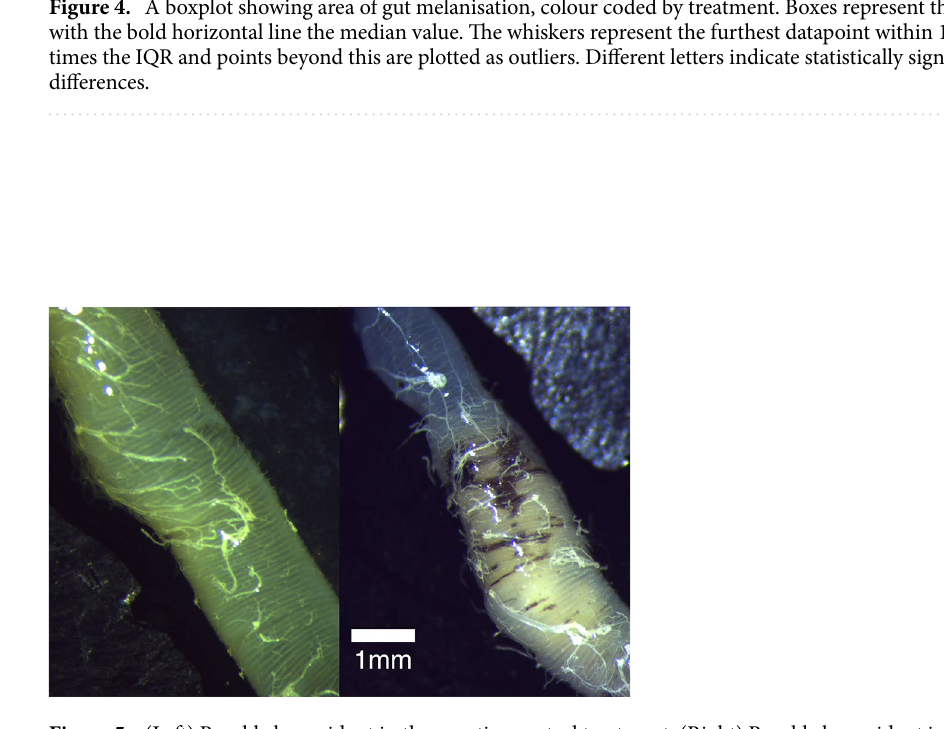
Figure 5. (Left) Bumble bee midgut in the negative control treatment. (Right) Bumble bee midgut in the co-formulant mixture treatment, which contains alcohol ethoxylates. The dark brown patches are areas of melanisation, indicative of damage to the gut. Both bees survived the full 120